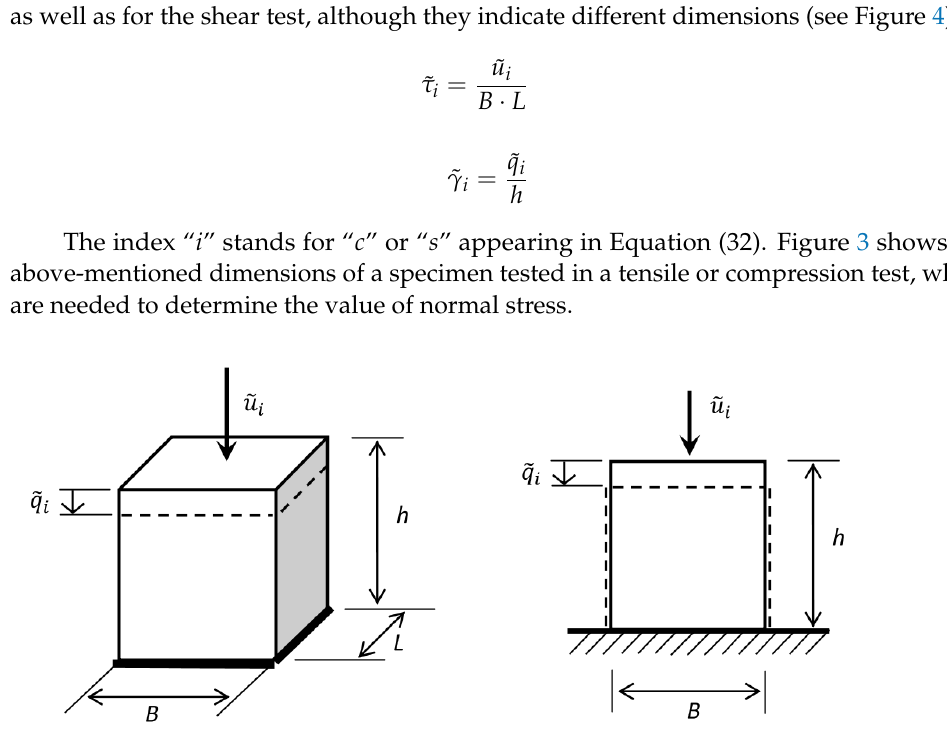
Figure 3. The desired dimensions of the sample tested in the compression